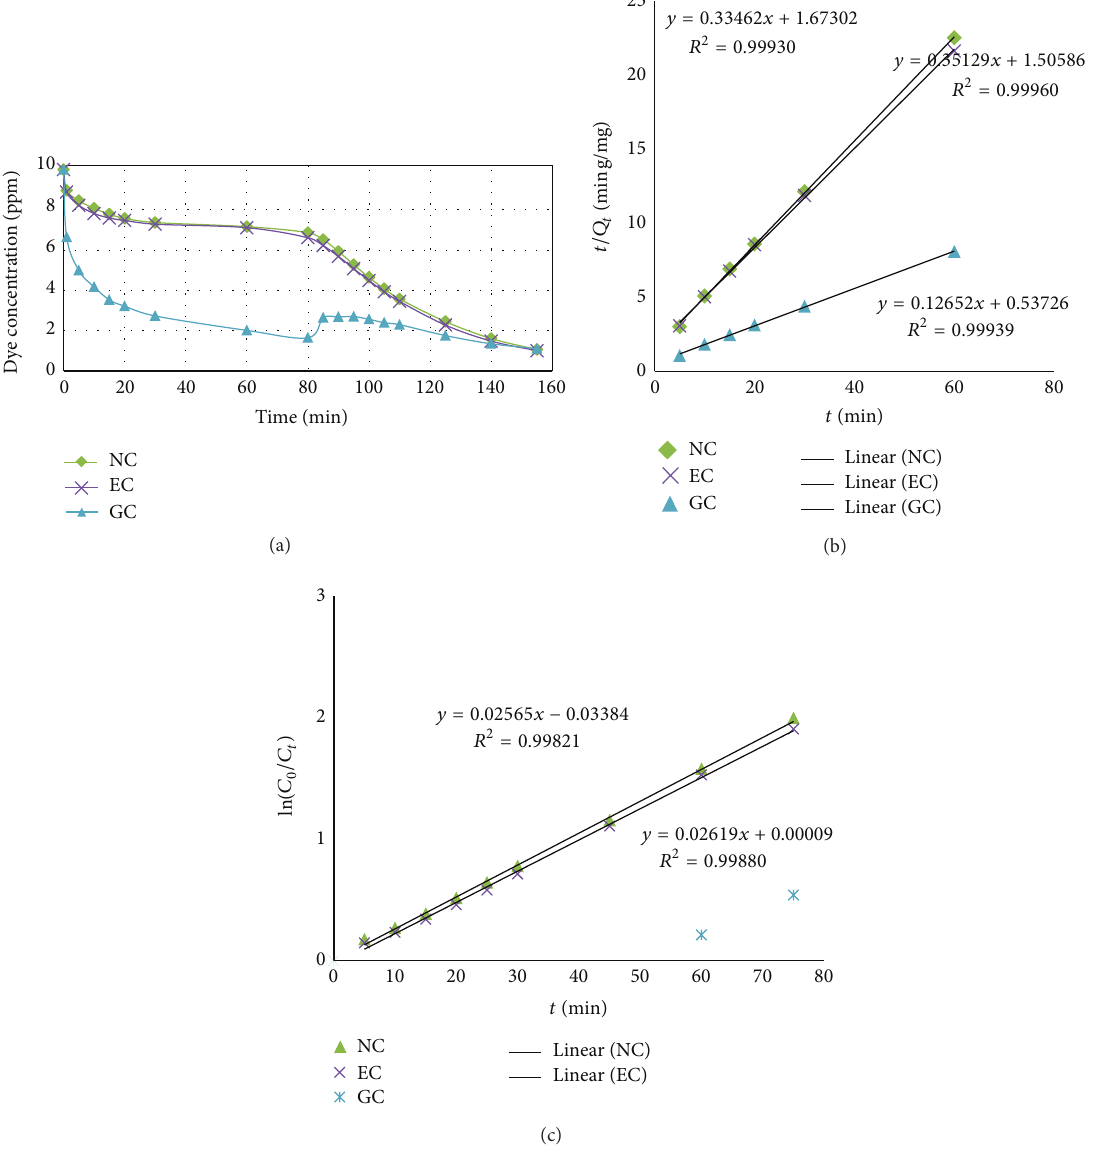
Figure 9: (a) Methyl orange adsorption-photodegradation curves (abbreviations: NC, EC, and GC) denote noncross-linked, epichlorohydrin cross-linked and glutaraldehyde, cross-linked chitosan catalyst composites, respectively. (b) The corresponding linearized plots of pseudo- second order adsorption kinetics. (c) The corresponding linearized plots of pseudo-first order photodegradation